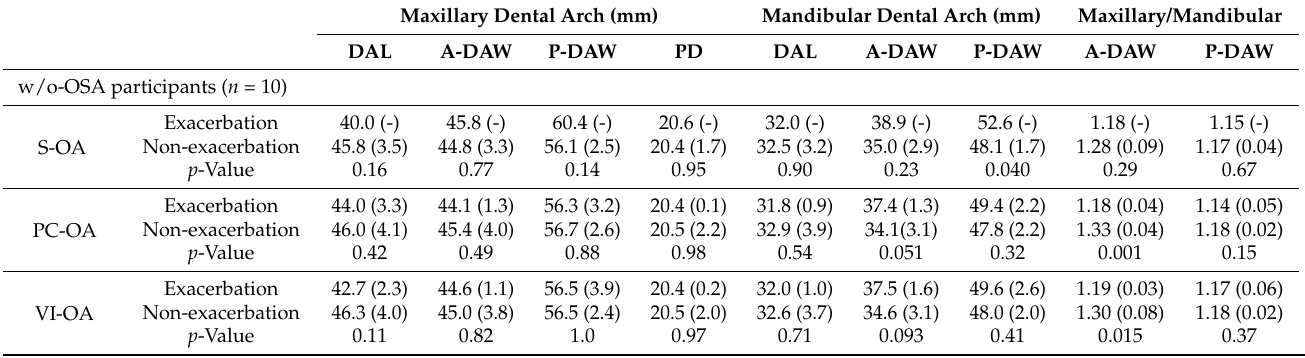
Table 3. The relationship between changes in respiratory status and dentition morphology in types of